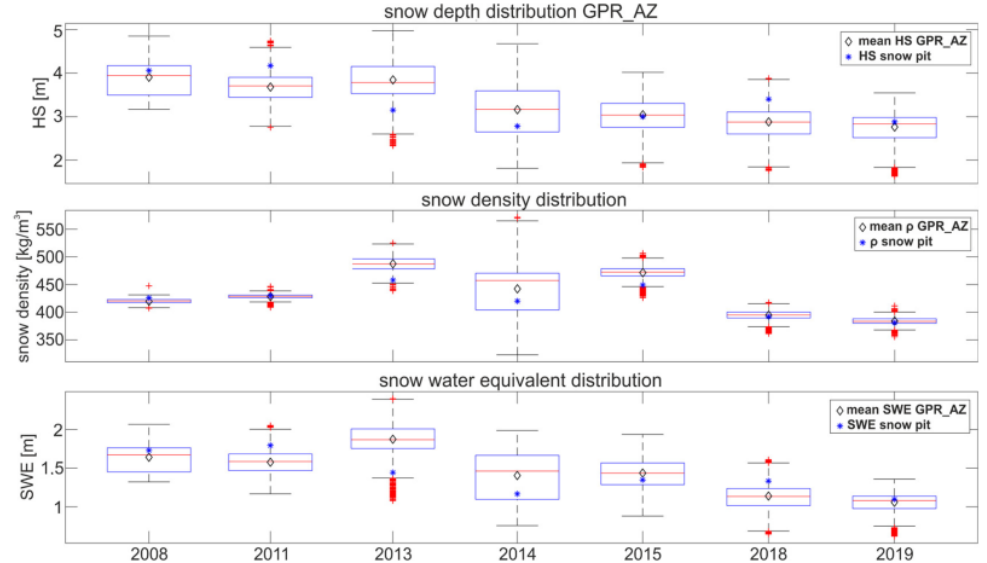
Figure 3. Distribution of GPR-derived snow depth (HS), density, and snow water equivalent (SWE) along the GPR_AZ profile. On each box, the central line indicates the median, and the bottom and top edges of the box indicate the 25th and 75th percentiles, respectively. The whiskers that extend to the most extreme data points are not considered outliers, and the outliers are plotted individually as dots. Mean HS, snow density, and SWE are represented by yellow diamonds and blue stars for the GPR_AZ profile and snow pit,